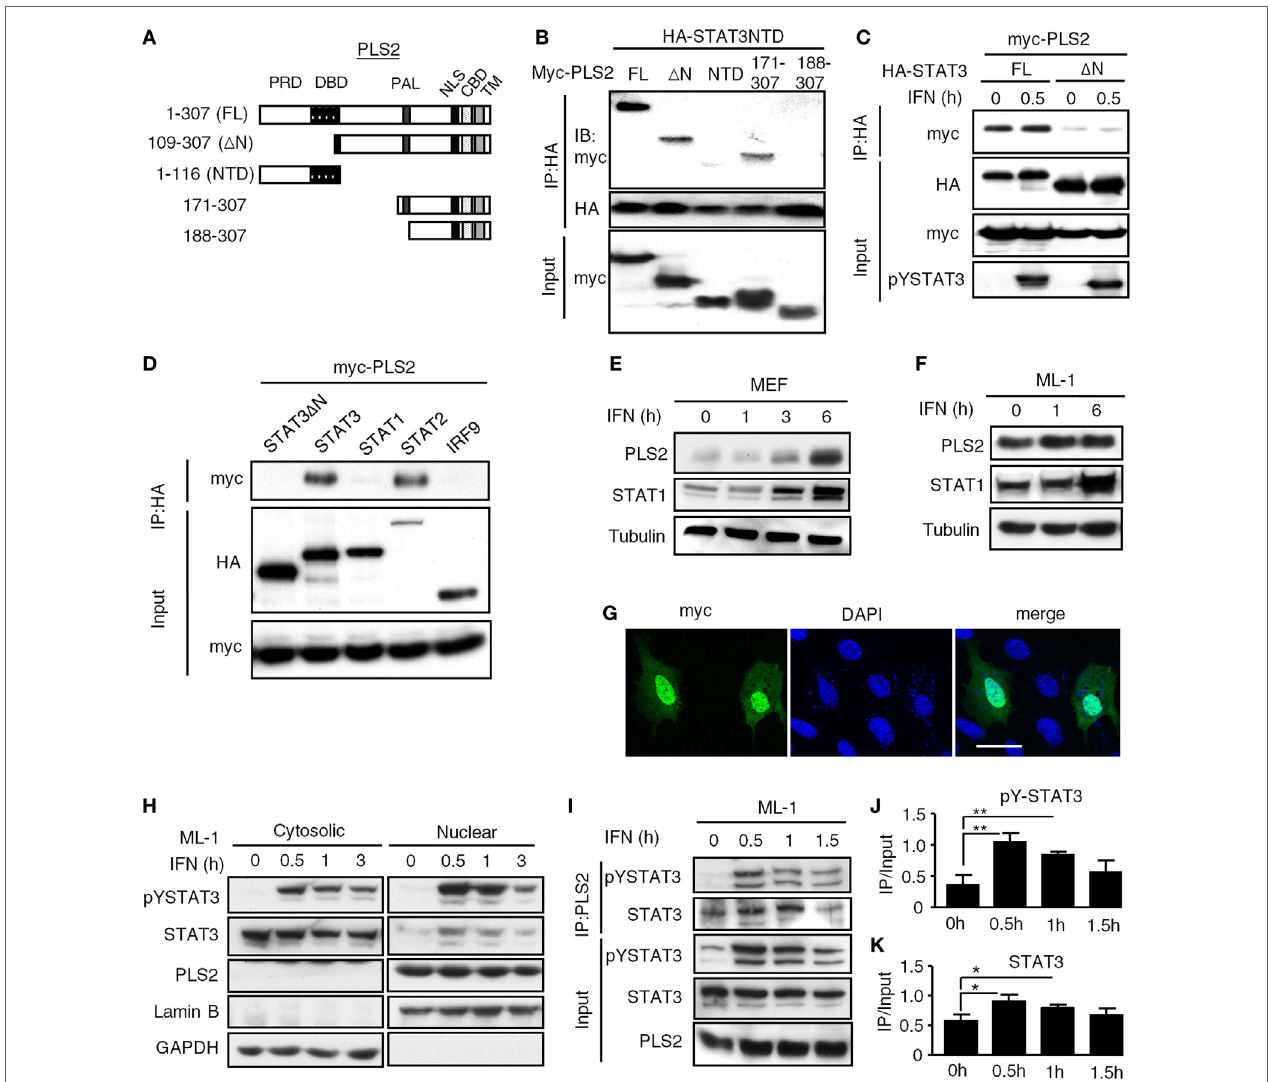
FigUre 1 | Phospholipid scramblase 2 (PLSCR2) is an IFN-inducible nuclear protein that interacts with the STAT3 N-terminal domain (NTD). (a) Schematic diagram of PLSCR2 full-length and truncated mutants. Abbreviations: PRD, proline-rich domain; DBD, DNA-binding domain; PAL, palmitoylation domain; NLS, nuclear localization signal; CBD, calcium-binding domain; TM, transmembrane domain. (B) HEK293T cells were transfected with HA-STAT3 NTD and myc-PLSCR2 (FL), PLSCR2 109–307 ( Δ N), PLSCR2 1–116 (NTD), PLSCR2 171–307 , or PLSCR2 188–307 , followed by co-IP with anti-HA antibody and immunoblotting with antibodies against myc and HA, respectively. Total lysates subjected to immunoblotting with anti-myc antibody were used as the input control. Blots are representative of two independent experiments. (c) HEK293T cells were transfected with HA-STAT3 (FL) or STAT3 135–770 ( Δ N) and myc-PLSCR2 and then treated with human IFN- α 2 (1,000 U/ml) for 30 m, followed by co-IP assay as described in panel (B) . Total lysates subjected to immunoblotting with anti-myc or pYSTAT3 antibody were used as the input control. Blots are representative of two independent experiments. (D) HEK293T cells were cotransfected with Myc-PLSCR2 and HA-tagged STAT3, STAT3 135–770 (STAT3 Δ N), STAT1, STAT2, or IRF9. The cell lysates were subjected to co-IP as in panel (B) . Total lysates subjected to immunoblotting with antibodies against HA or Myc were used as the input control. Blots are representative of two independent experiments. (e,F) WT mouse embryonic fibroblast (MEF) (e) or ML-1 (F) cells were treated with mouse IFN- α 4 (1,000 U/ml) for the indicated times. Total cell lysates were subjected to immunoblotting with antibodies against PLSCR2, STAT1, or tubulin. Blots are representative of two independent experiments. (g) WT MEFs were transfected with myc-PLSCR2 for 24 h, fixed, and then stained with anti-myc antibody and FITC-conjugated anti-mouse IgG and DAPI. Samples were visualized by confocal microscopy. Images are representative three independent experiments. Scale bar = 25 µm. (h) ML-1 cells were stimulated with mouse IFN- α 4 (1,000 U/ml) for the indicated times. Cytosolic and nuclear extracts were subjected to immunoblotting with antibodies against PLSCR2, phospho- STAT3, STAT3, lamin B, or GAPDH. Blots are representative of two independent experiments. (i) ML-1 cells stimulated with mouse IFN- α 4 (1,000 U/ml) for the indicated times were immunoprecipitated with anti-PLSCR2 antibody and immunoblotted with antibodies against pSTAT3 and STAT3. Total cell lysates subjected to immunoblotting with antibodies against pYSTAT3, STAT3, and PLSCR2 were used as the input control. Blots are representative of three independent experiments. (J,K) Quantification of co-immunoprecipitated pY-STAT3 (J) and STAT3 (K) with PLSCR2 was done by normalizing to input signals using ImageJ. Data are shown as mean ± SD, * p < 0.05, ** p <